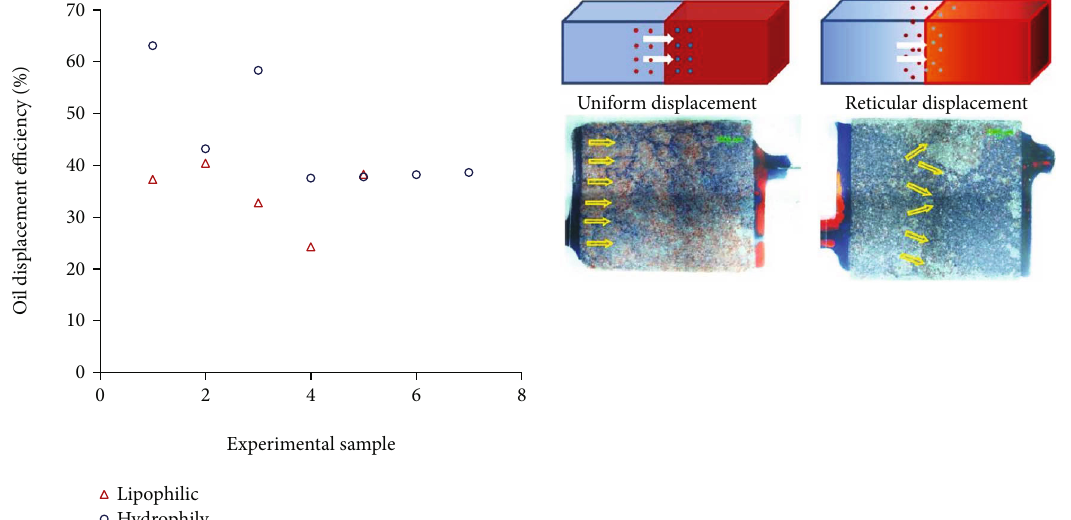
Figure 8: The relationship between di ff erent wetting phases and oil displacement e ffi ciency (red dots represent oil and blue dots represent